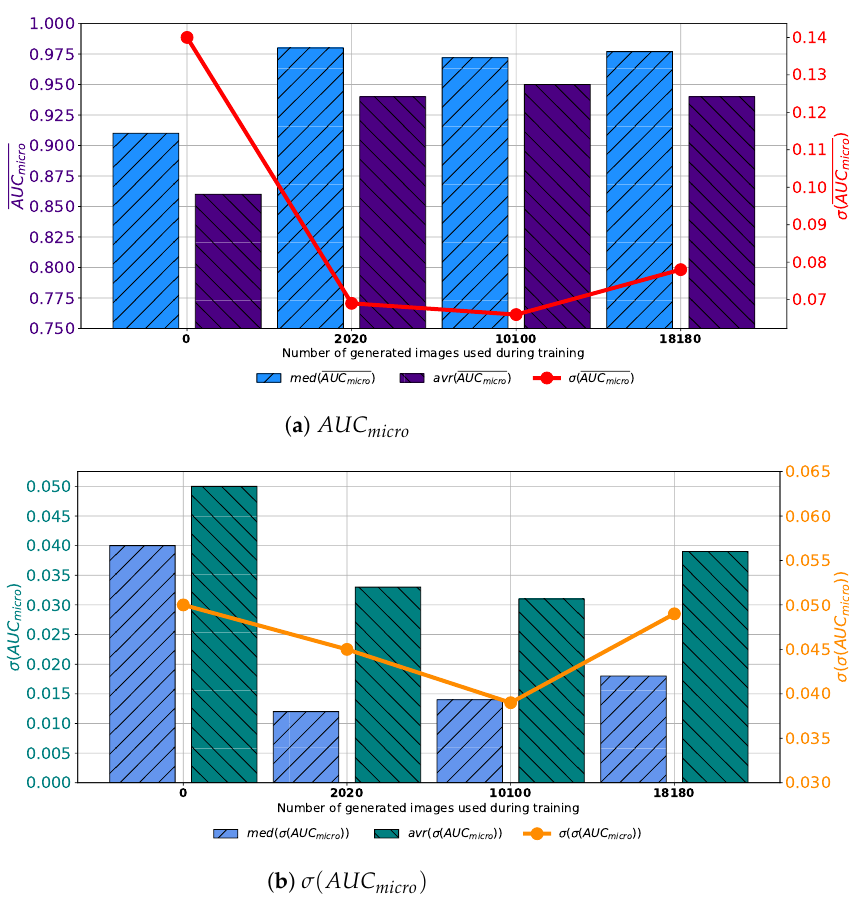
Figure 9. Median, average AUC micro and standard deviation of AUC micro and σ ( AUC micro ) for the case of AlexNet trained with images generated by GAN in 500